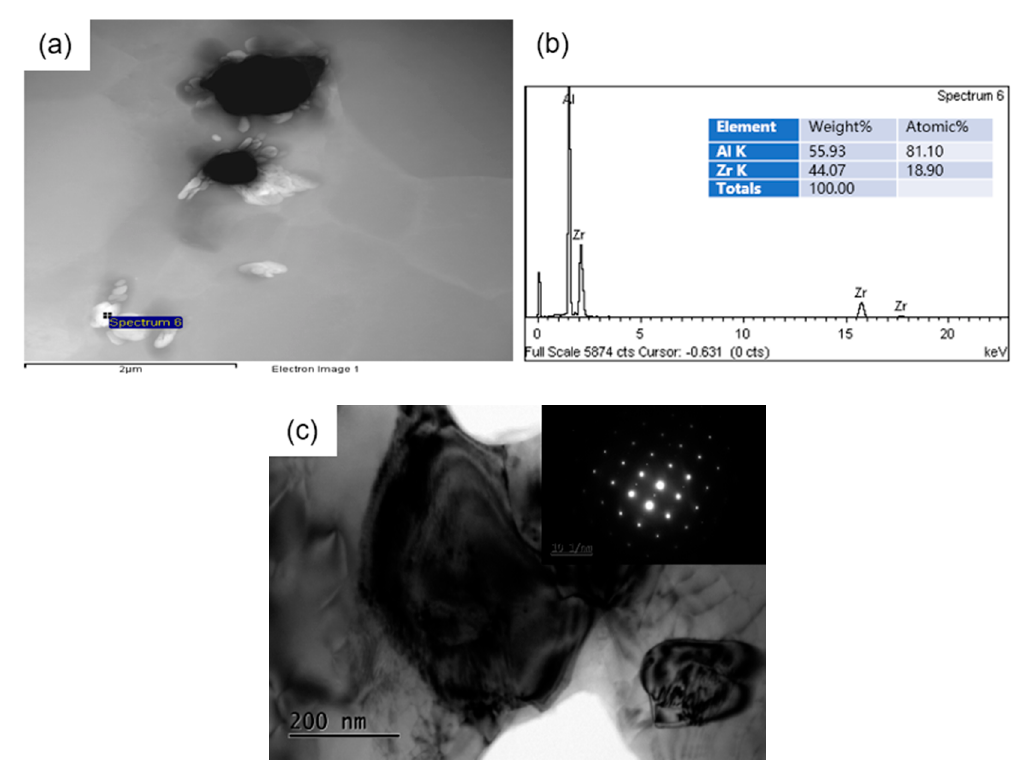
Figure 6. Al 3 Zr distribution in the Al-Zn-Mg-Cu-Zr alloy with IC-AEMS treatment: ( a ) TEM low magnification image; ( b ) EDS analysis corresponding to spectrum 6; ( c ) The bright-field TEM images and selected area electron diffraction (SAED) patterns taken from the particle Al3Zr and the adjacent aluminum matrix.